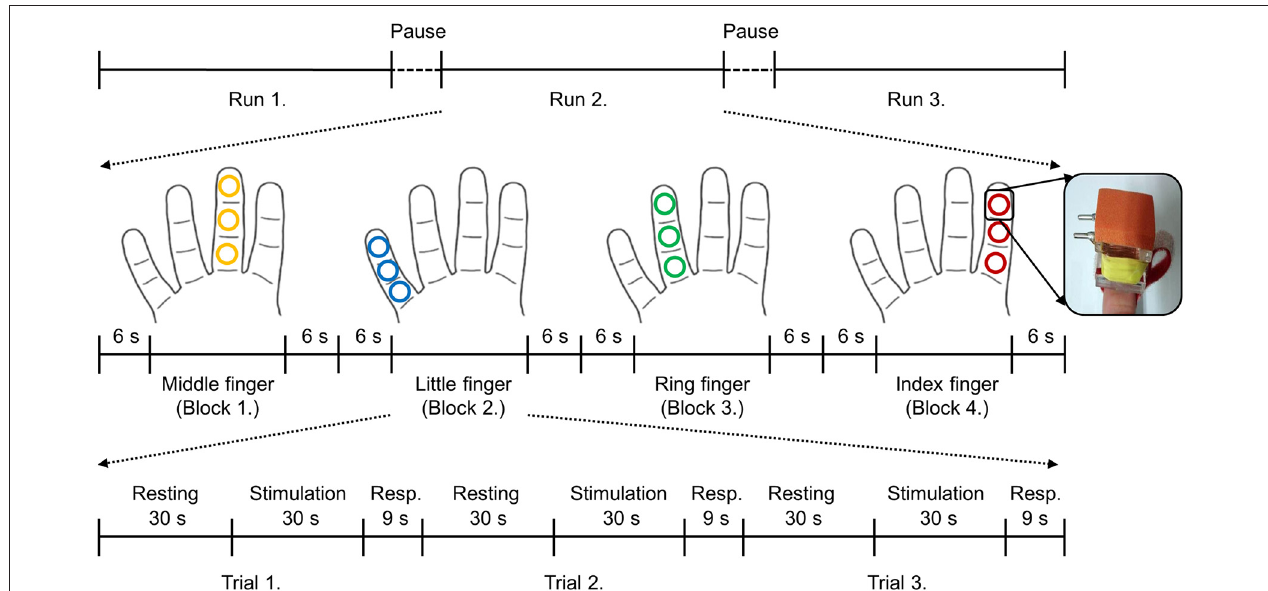
stimulation, participants were asked to press the button with their left hand if they perceived the stimulation regardless of the stimulus locations. Stimulated locations of each finger are depicted in the same color. Even though each finger was stimulated at three different sites, those were considered as the same finger locations in this